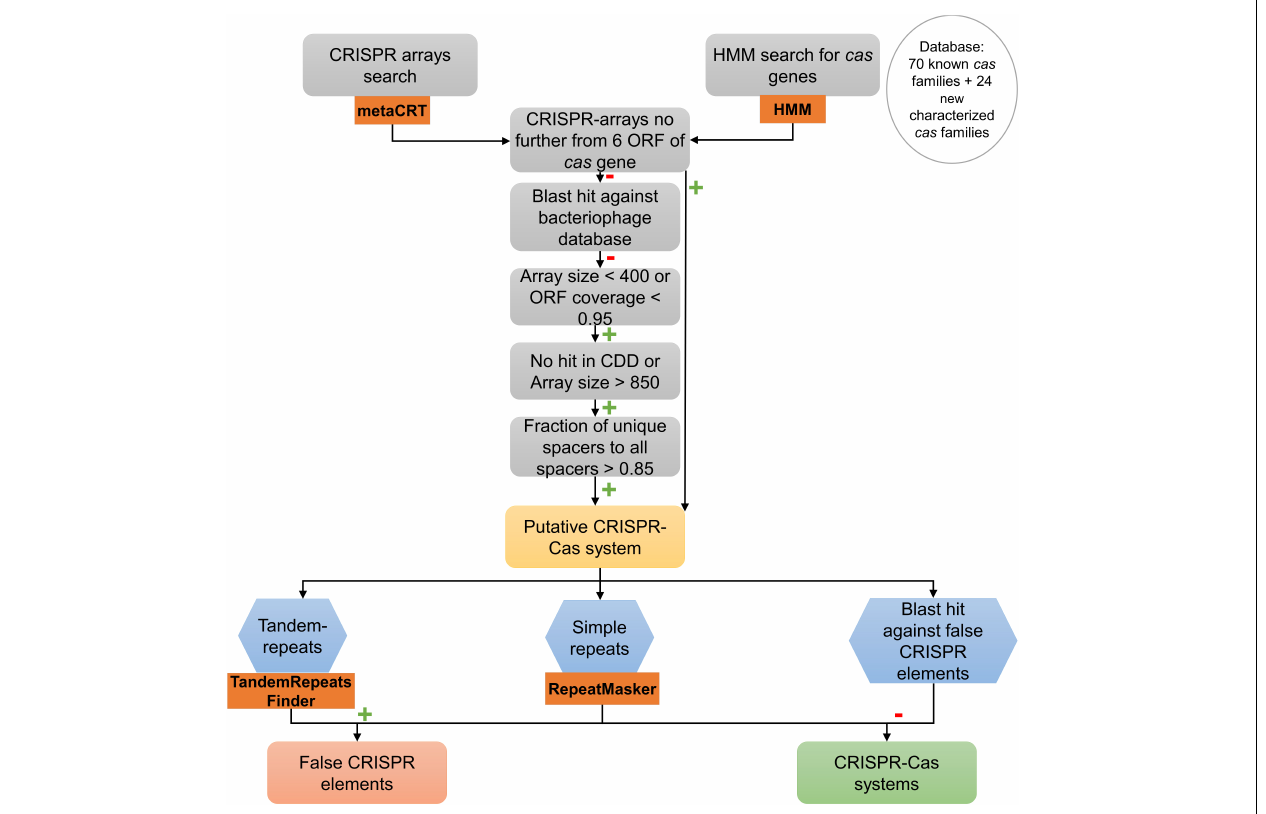
FIGURE 2 | Search procedure of CRISPR-Cas systems in 18 genomes of A. baumannii clinical strains. Orange rectangle represents bioinformatics programs used for that task. Green plus marks represent a positive result for each operation. Red minus marks represent a negative result for each operation.